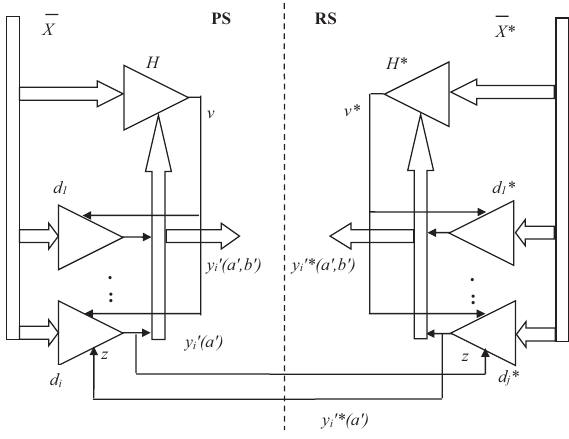
Figure 5 . Diagram of establishing interrelation between d i and d (cid:2) i